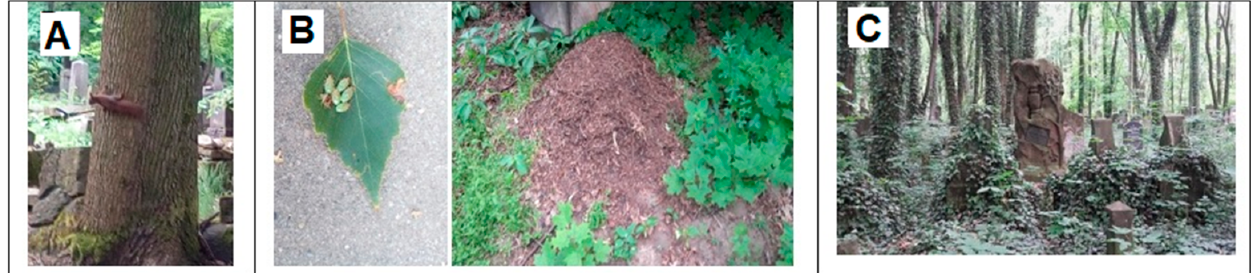
Figure 5. Wildlife and tombstones in Jewish cemeteries in Ł ód ź and Leipzig. Legend: ( A )—sequel, ( B )—two examples of insect groups, ( C )—creepers Hedera helix . Photographs: A. D ł ugo ń ski.